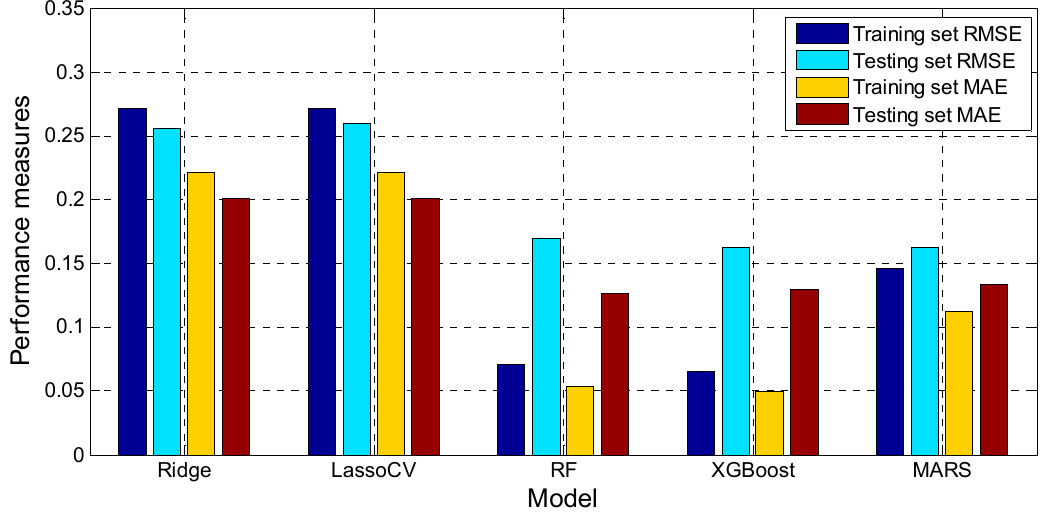
Figure 33. Performance measures of the Ridge, Lasso, RF, XGBoost, and MARS model.